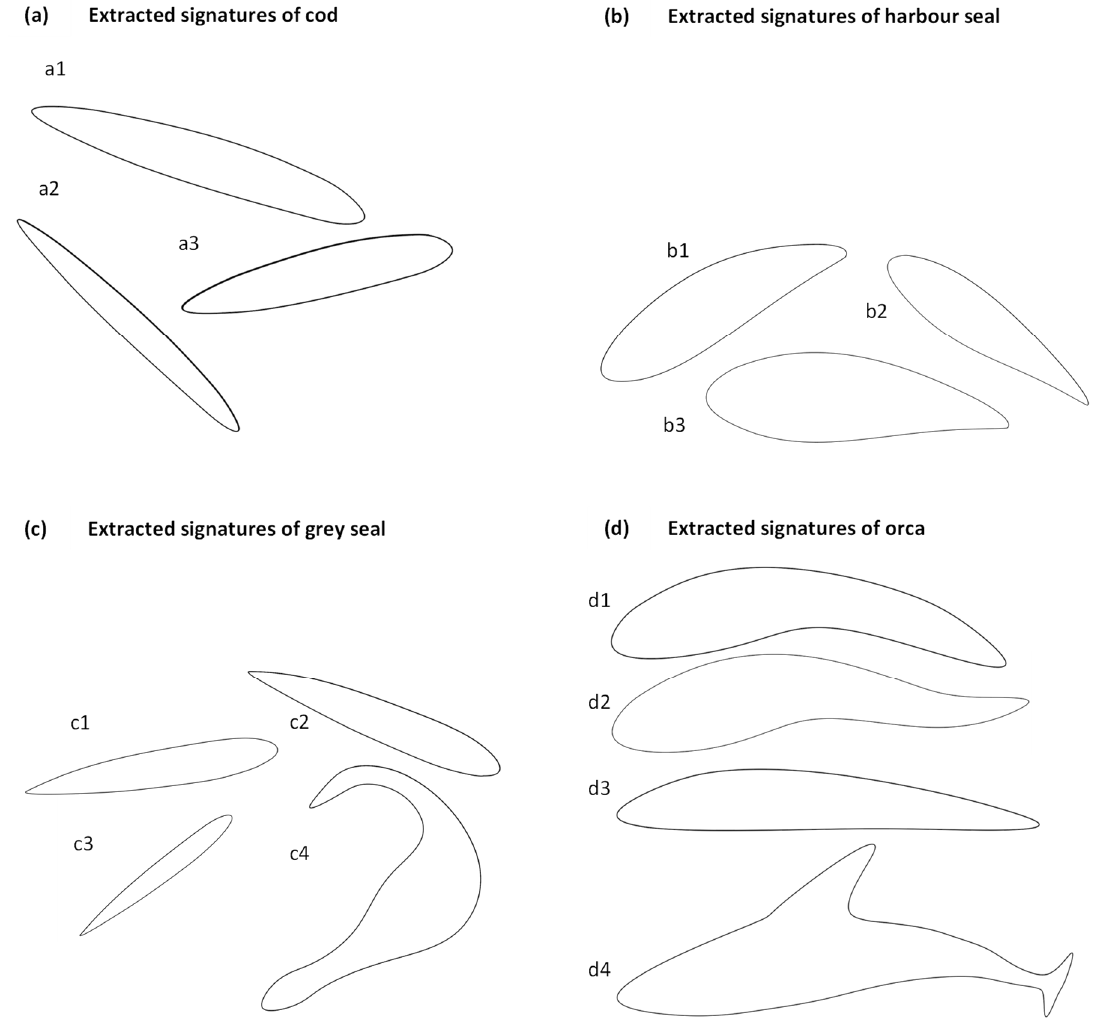
Figure 10. Visual signatures extracted from acoustic imaging of ( a ) cod, ( b ) harbour seals, ( c ) gray seals and ( d ) orcas. The shapes were extrapolated from several acoustic images and reconstructed using Solidworks .